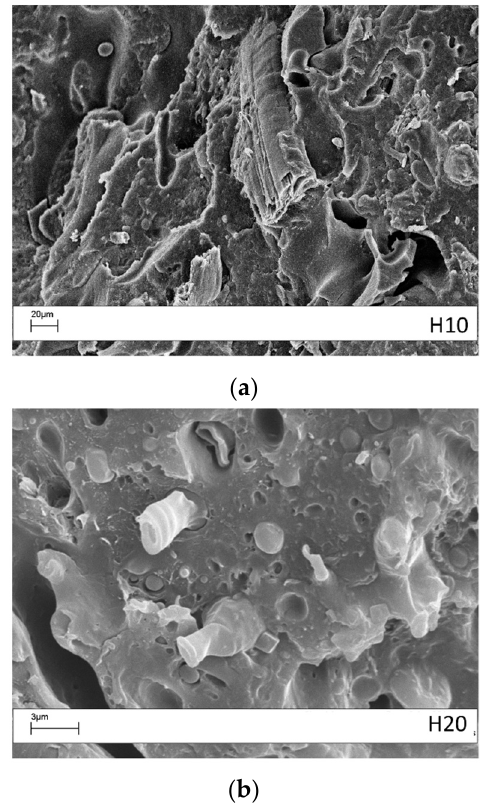
Figure 8. Scanning electron miscroscopy analysis of the tensile fractured 60/40 PP/LV blend with different content of hemp fibers: ( a ) 10 wt.% (H10); ( b ) 20 wt.% (H20).